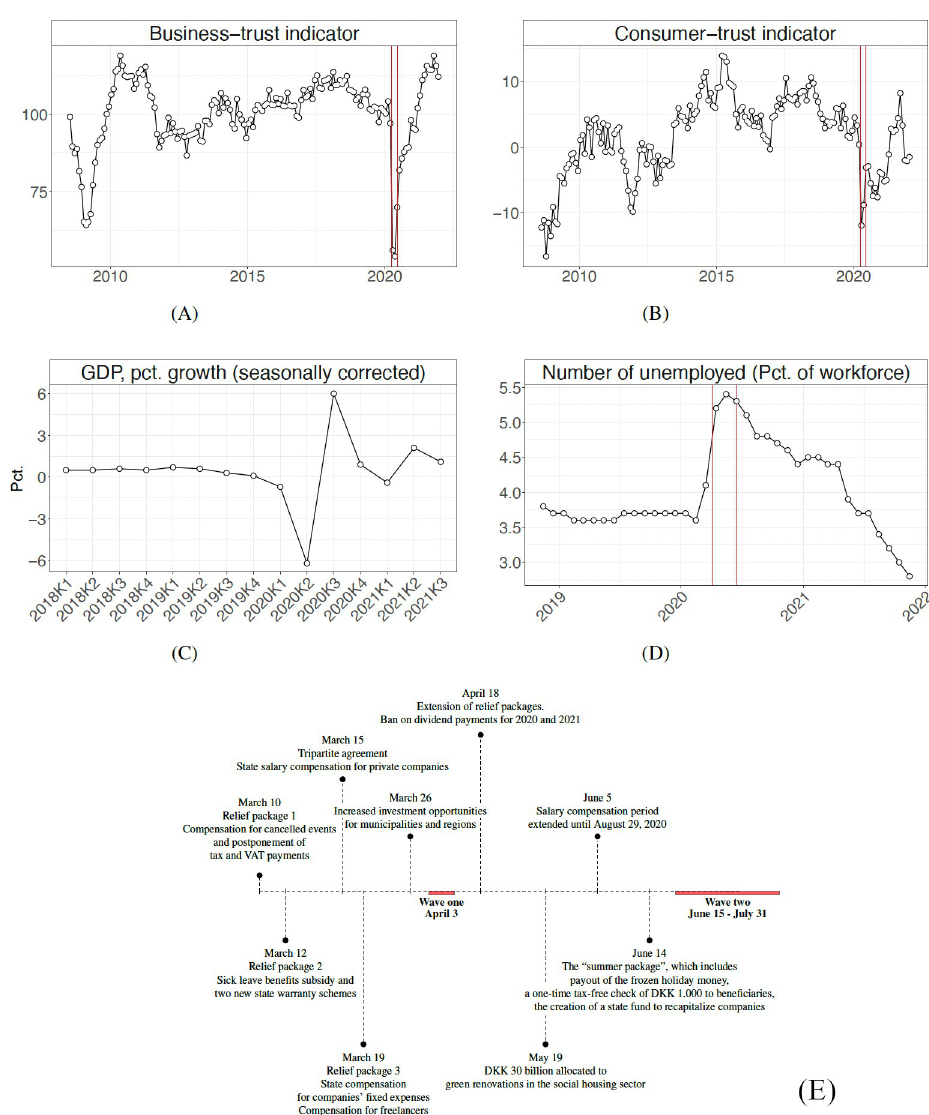
Fig 1. Development in business (Panel A, monthly) and consumer trust (Panel B, monthly), GDP (Panel C, quarterly) and unemployment (Panel D, monthly). Panel E shows economic initiatives to combat COVID-19. Red lines indicate invitation to the two survey